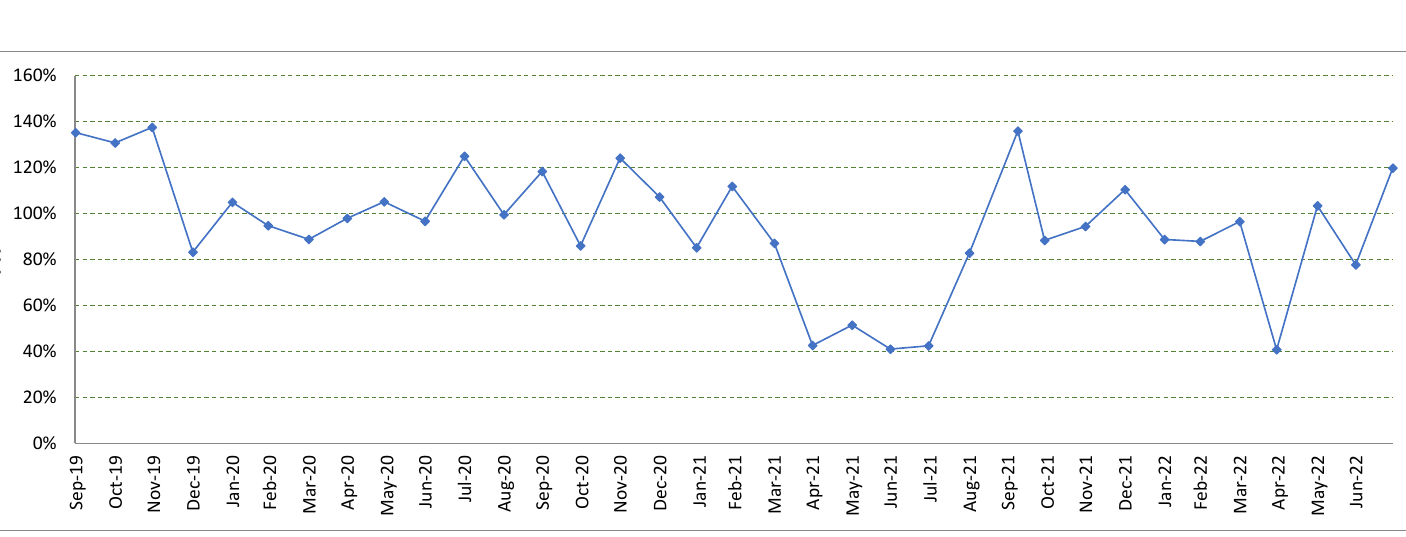
Figure 8. Semi-variance portfolio: long only. J. Risk Financial Manag. 2022 , 15 , x FOR PEER REVIEW